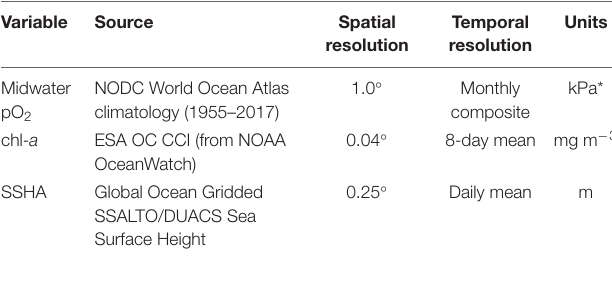
TABLE 1 | Environmental variables used to build statistical models for deep scattering layer (DSL) depth and vertical migration proportion (DVM p